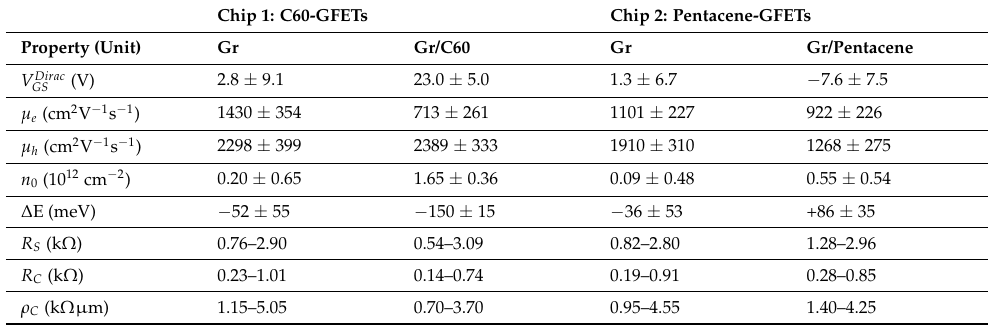
Table 1. Summary of the electrical properties of the GFETs before and after deposition of the C60 and Pentacene molecules. The table shows the mean and variance of the normal distributions of V Dirac , GS µ e and µ h in Figure 3e–j. The residual doping of graphene is calculated considering the mean and variance values of V Dirac in Equation (1) before and after deposition of the molecules. The Fermi GS energy shift ∆ E F is calculated using the energy dispersion relation of graphene and residual doping. The table shows the minimum and maximum values of the gate-dependent sheet resistance ( R S ) and W is calculated using contact resistance ( R C ) presented in Figure 4. The contact resistivity ρ C = R C the channel width W = 5 µ